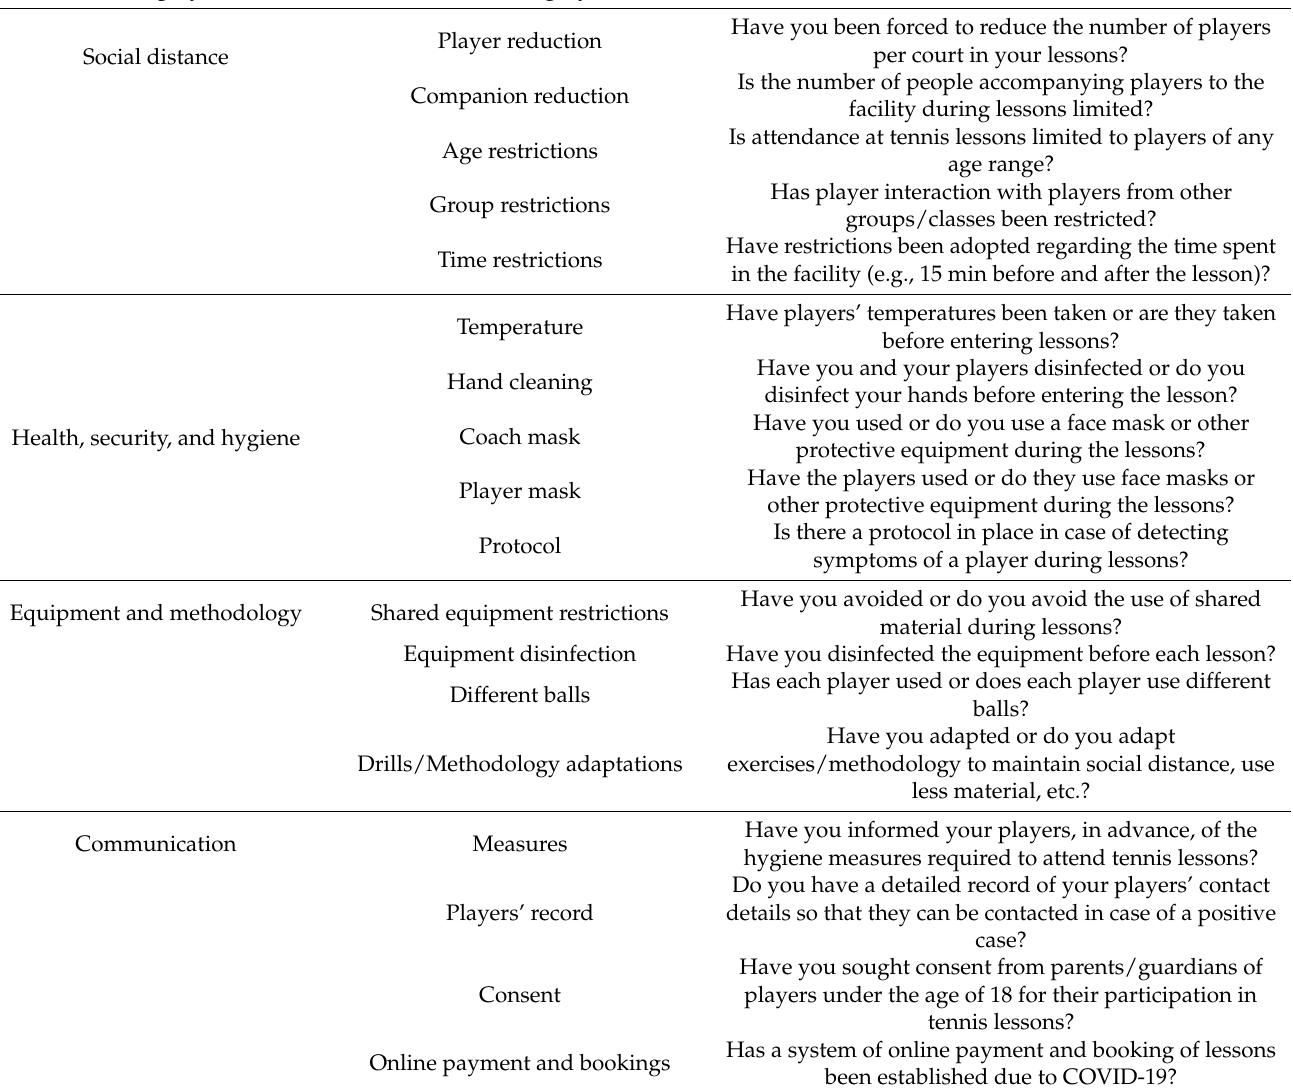
Table 1. Categories and sub-categories included in the survey of the